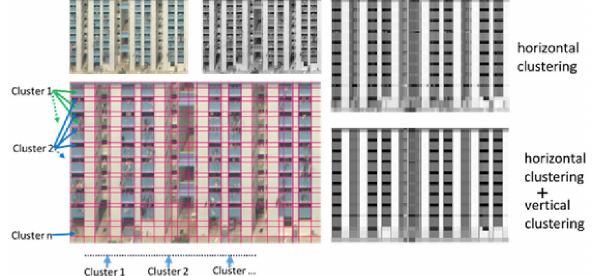
Figure 11. Spatially unrelated image orthographic clustering and segmentation.